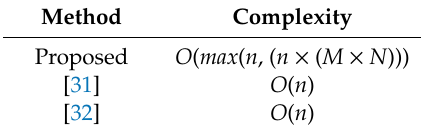
Table 6. Comparison of computational complexity between the proposed approach and other